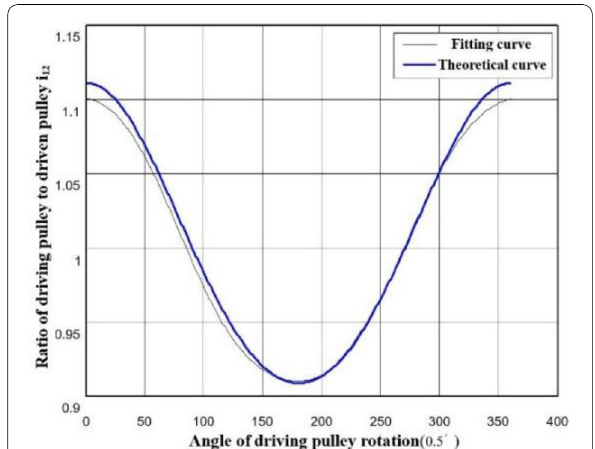
Figure 18 Comparison of analogy results of master–slave